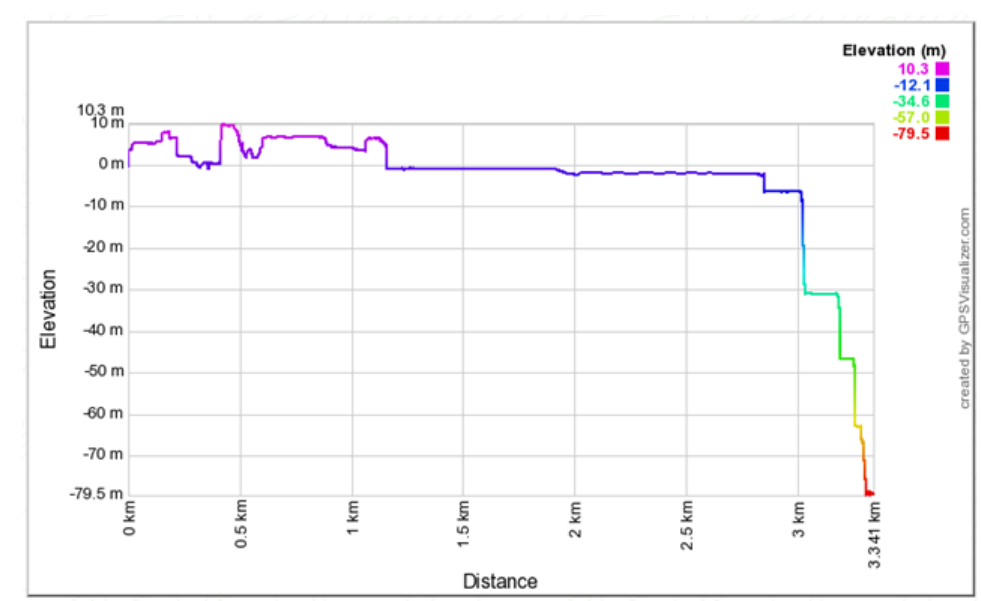
Figure 11. Flight